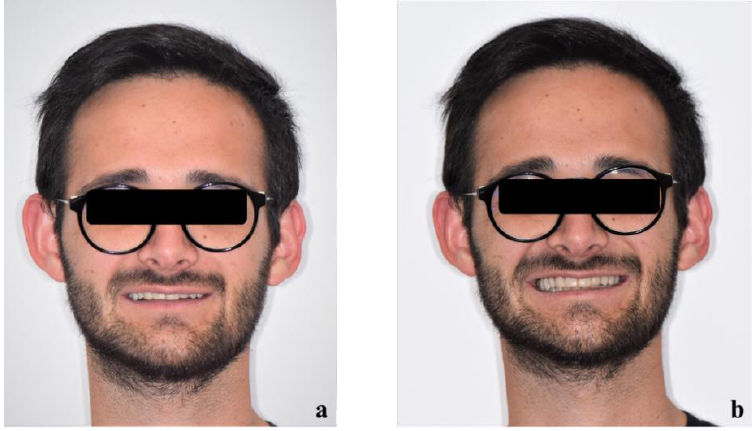
Figure 15. Extraoral examination at the end of the treatment: smile of the patient ( a ) and forced smile